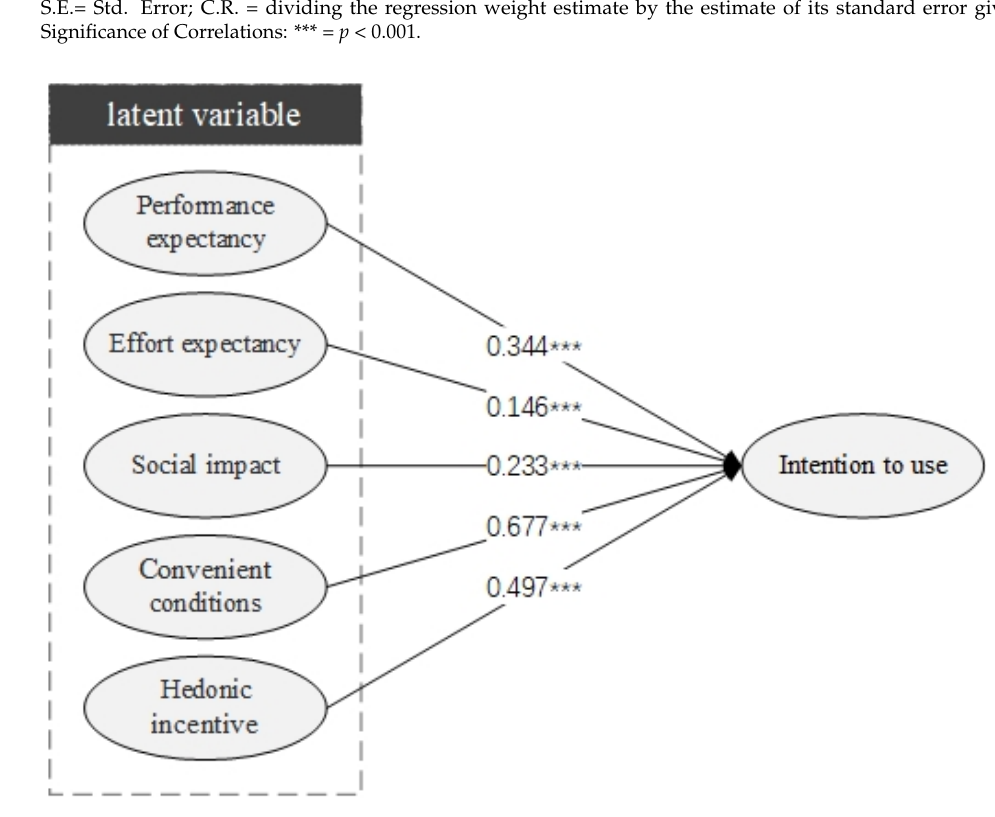
Figure 13. Findings from tests of hypotheses (Note: *** denote 1% significance